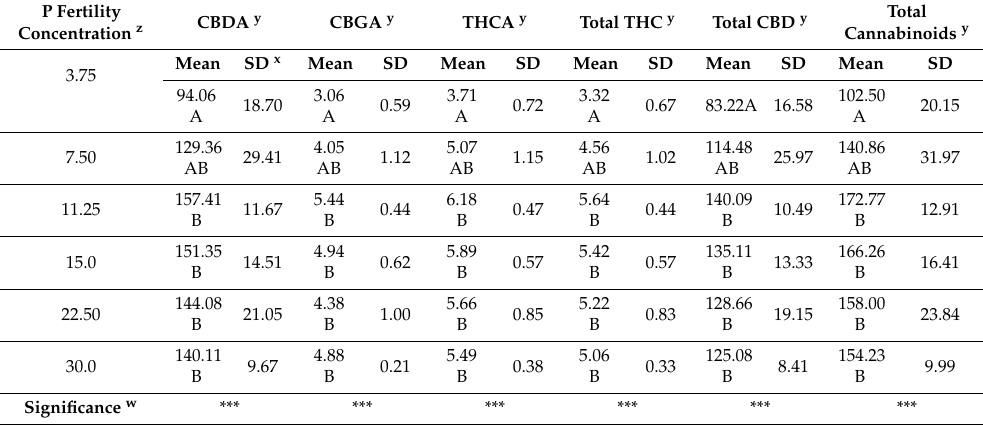
Table 8. The impacts of phosphorus (P) fertility on acid cannabinoid pools, total THC, total CBD, and total cannabinoids of C. sativa “BaOx” floral material after eight weeks of critical night length (CNL) induction.